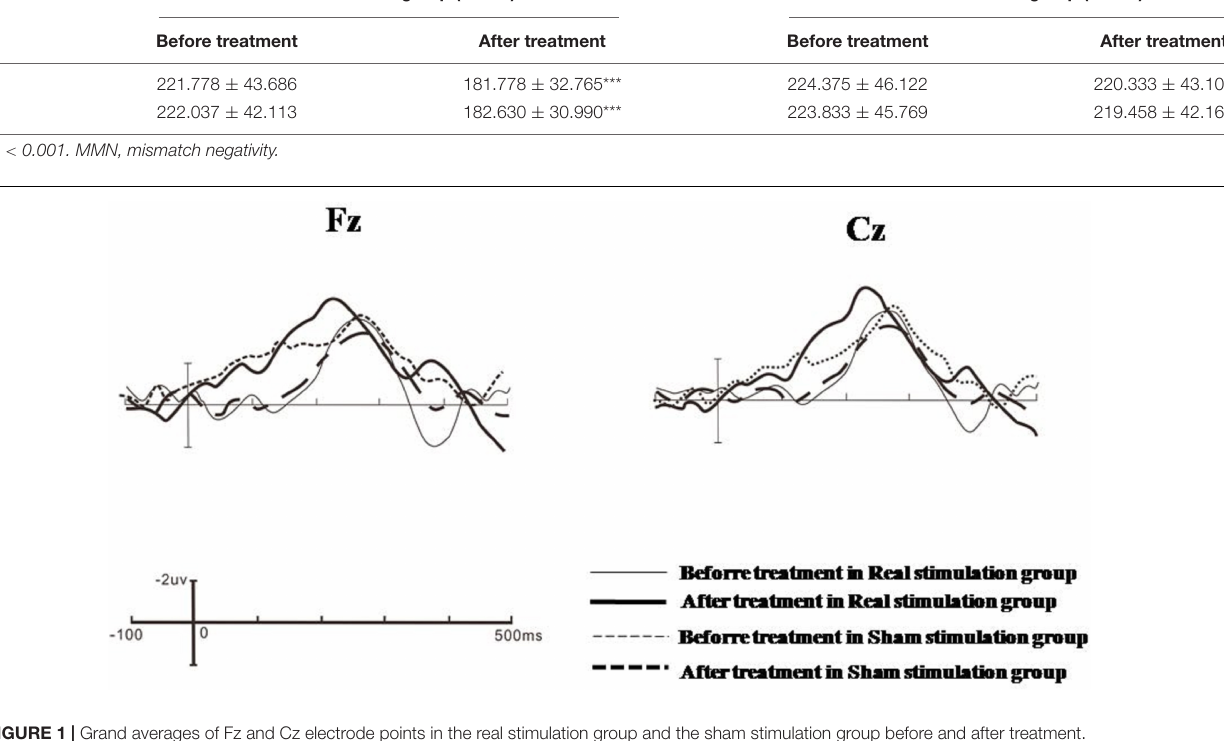
TABLE 4 | Comparison of MMN amplitude between the two groups before and after treatment ( ¯ x ± s). Real stimulation group ( n = 27) Sham stimulation group ( n = 24) Before treatment After treatment Before treatment